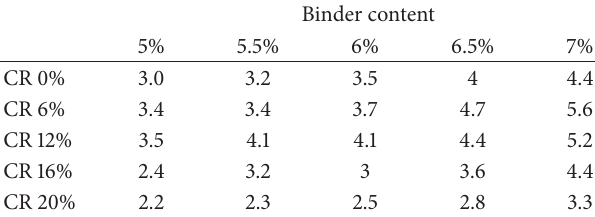
Table 6: Flow results (mm) for different CRM contents.